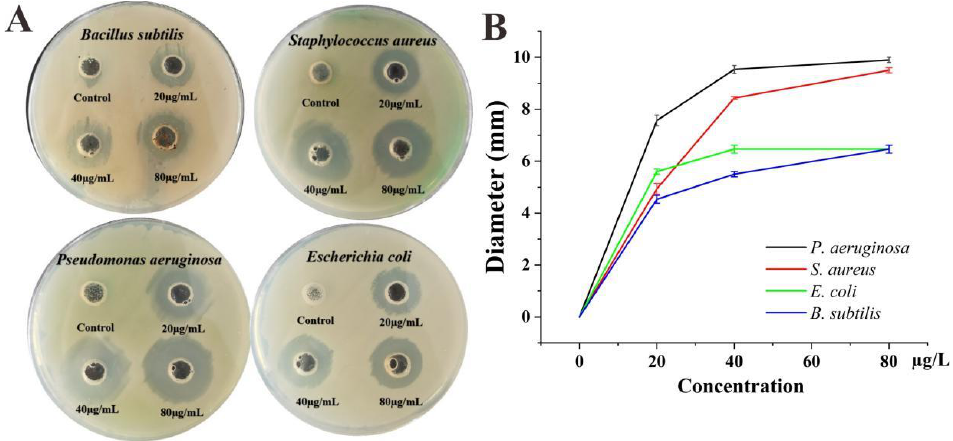
Figure 8. Antimicrobial activities of biogenic Ag@AgCl nanoparticles against S. aureus , P. aeruginosa , E. coli and B. subtilis : digital images ( A ) and inhibitory zone diameter ( B ).